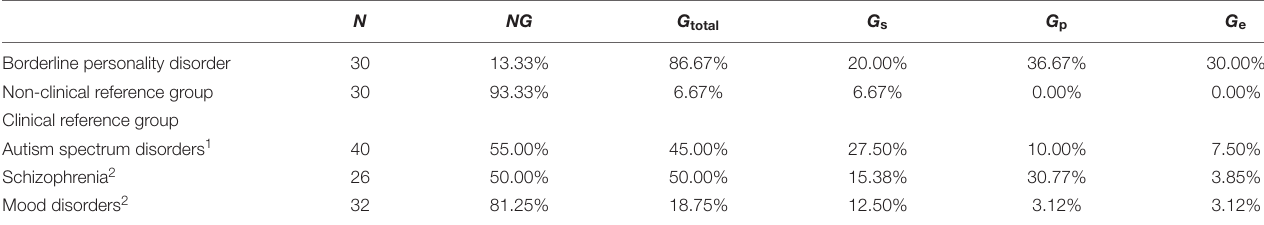
TABLE 1 | Percentages of individuals with no, slight, pronounced, and extreme gelotophobia summarized for patients with borderline personality disorders as well as non-clinical and clinical reference groups. N NG G